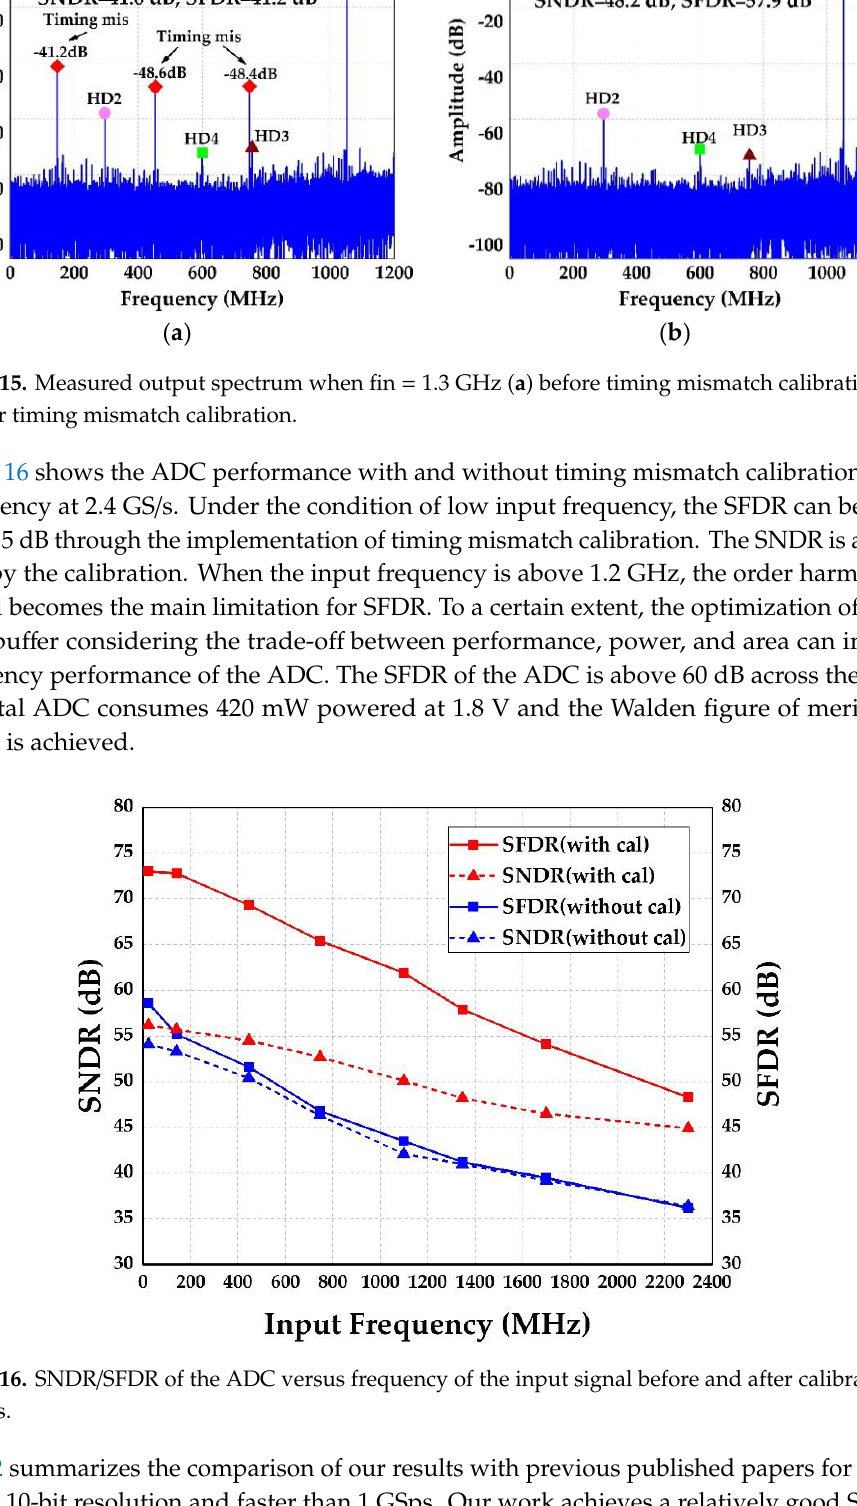
Figure 14. Convergence process of VDL control DAC output ( a ) when fin = 141 MHz and ( b ) when fin = 1.3 GHz.